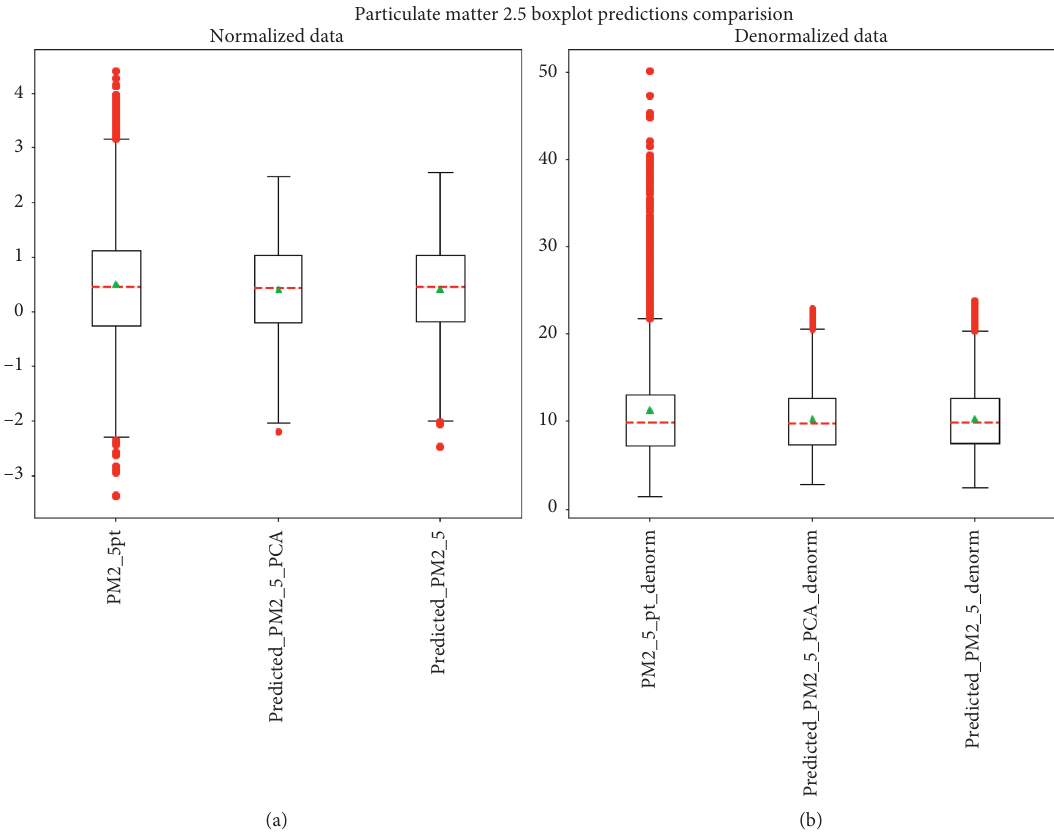
Figure 17: Boxplots of observed and forecasted particulate matter 2.5 values (PCA SVR-RBF and SVR-RBF, before and after Yeo-Johnson power Table 10: Forecasting models’ error metrics for particulate matter 2.5 measurements in the training and validation sets. PCA SVR-RBF SVR-RBF Error metrics Training set Validation set Training set Validation set